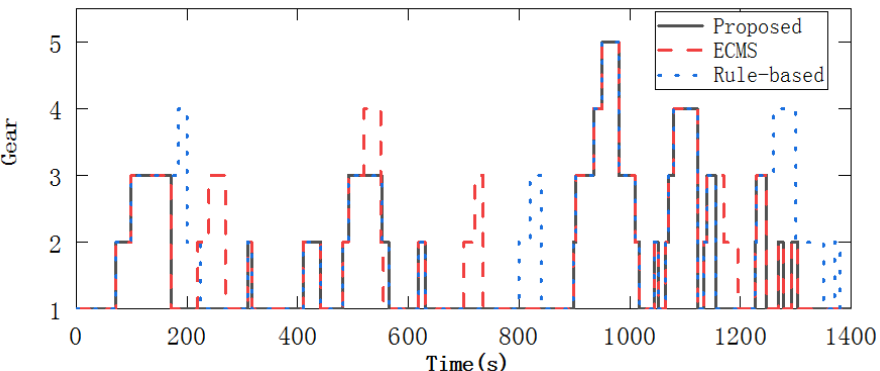
Figure 19. ATM gear-shifting frequency comparison between three strategies.